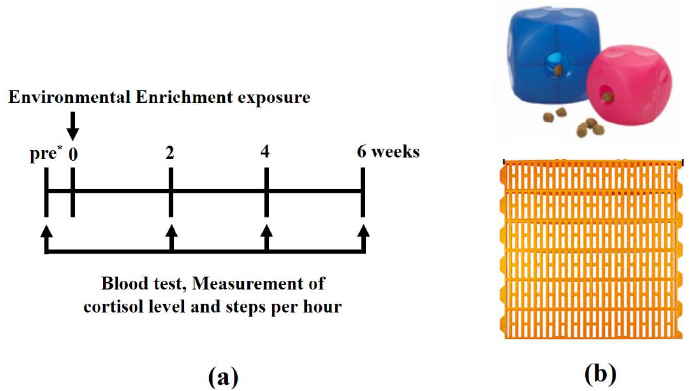
Figure 1. ( a ) Diagrammatic representation of the experimental protocol, * pre: before environmental enrichment exposure; ( b ) environmental enrichment materials (Buster soft cube, top; soft plastic floorboard,